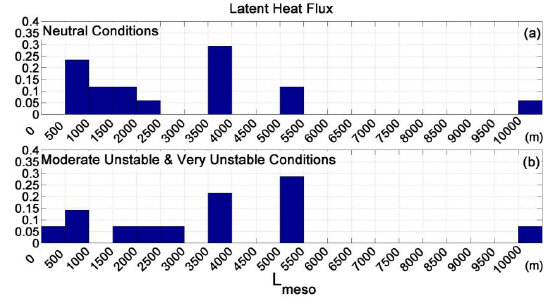
Figure 6. The frequency histograms of the wavelength ( L meso ) at which the sign reversal occurred for latent heat flux: ( a ) under near neutral conditions and ( b ) under moderately unstable and very unstable conditions. Wavelength interval for frequency histogram is 500 m.